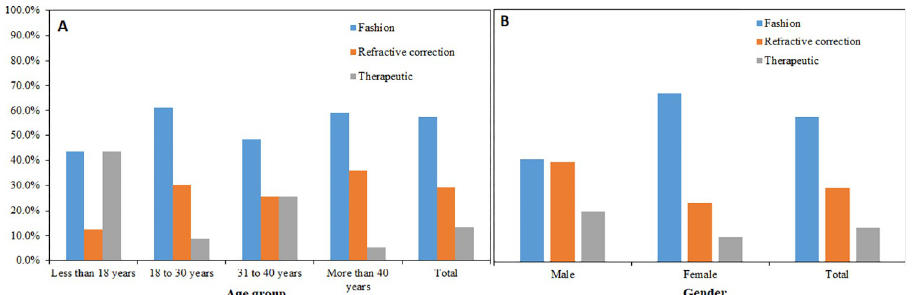
Fig 1. Distribution of purpose of contact lens wear by: (A) age group and (B), gender of wearers.